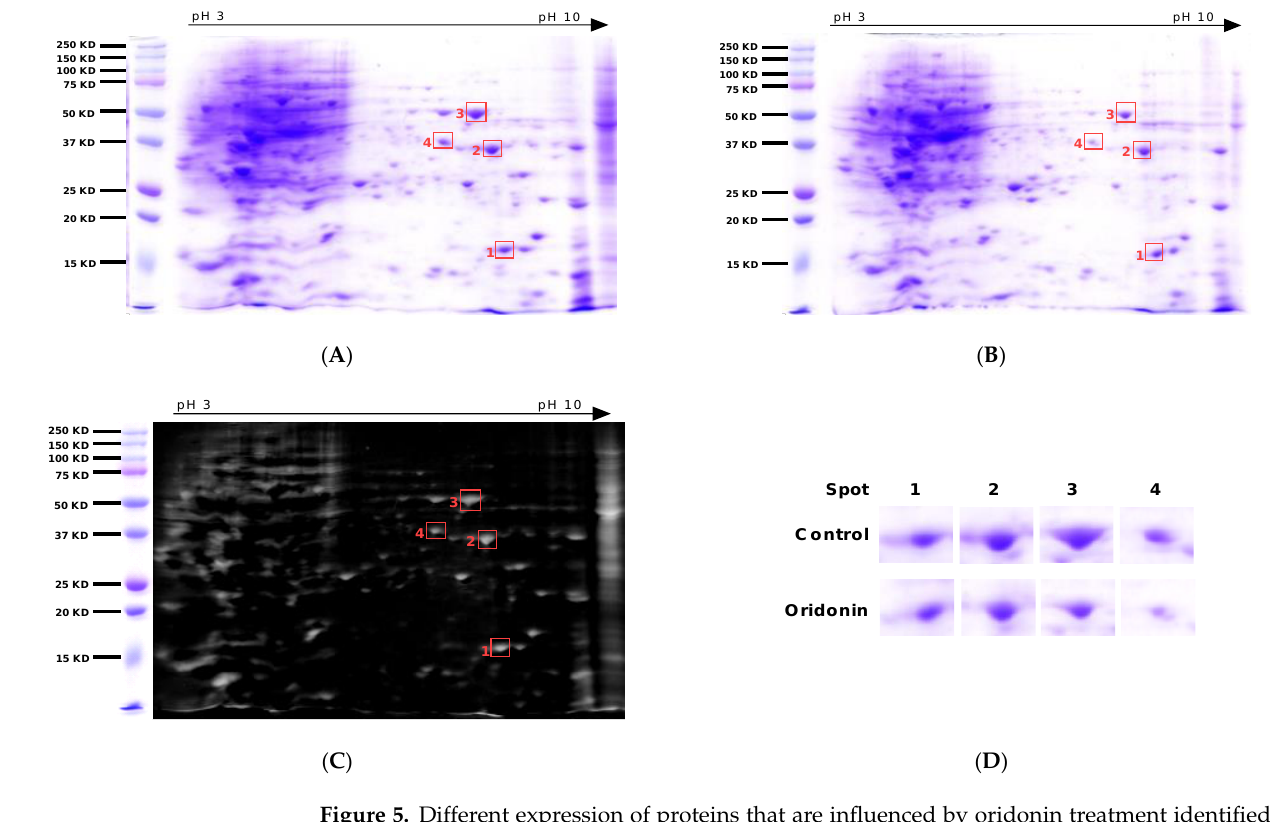
Figure 5. Different expression of proteins that are influenced by oridonin treatment identified by proteomics. ( A ) The global view of proteins of untreated TE-8 cells. ( B ) The global view of proteins of 40 µ M oridonin-treated TE-8 cells for 24 h. ( C ) Different expression of proteins of oridonin-treated to untreated TE-8 cell lysates. Cell lysates of same amount proteins were first separated by 7 cm IPG strips and then the SDS-PAGE gels for the second dimensional isolation. Finally, the gels were stained with Coomassie blue. Different expression of protein image was reached by the MATLAB image processing module. ( D ) Close-up spot images of pronounced changed protein spots. Table 1. Top Candidate Proteins Involved in Oridonin-treated ESCC.